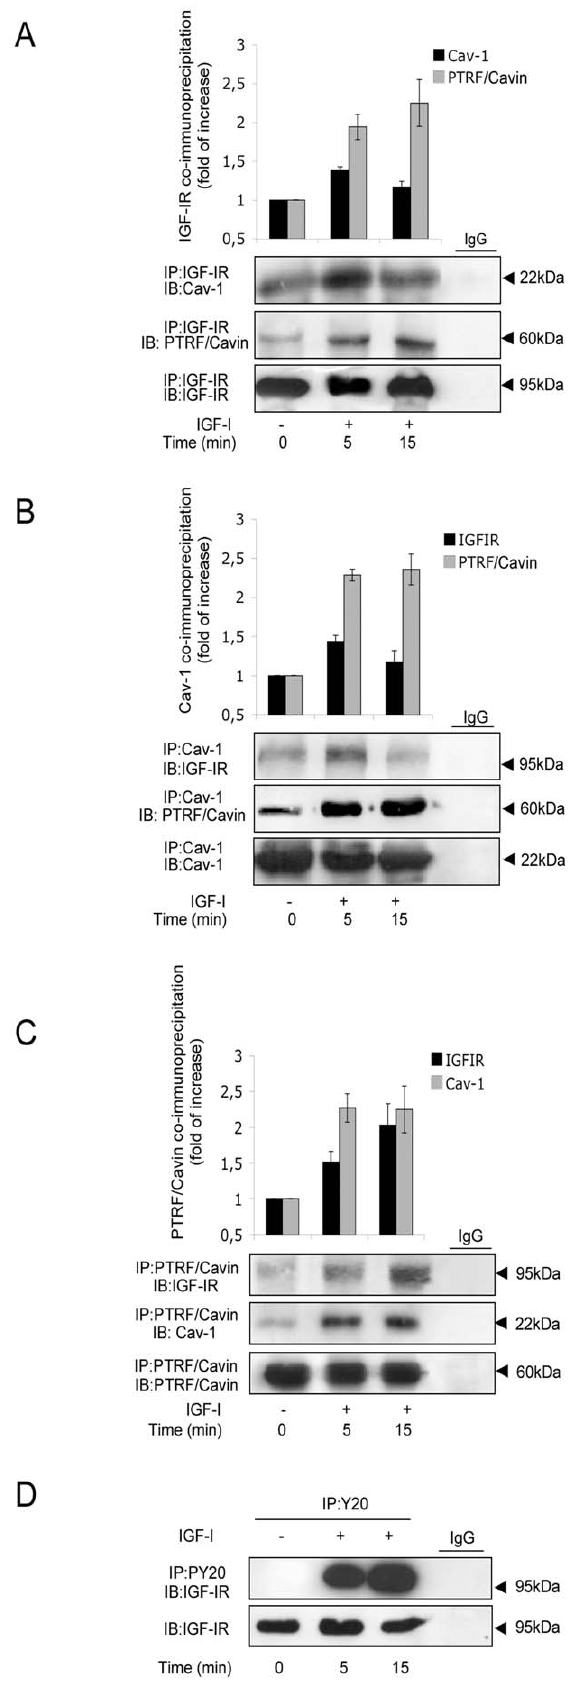
Figure 1. Cav-1 and PTRF/Cavin co-immunoprecipitation with IGF-IR. Serum starved HaCat cells were stimulated with IGF110 nM for the indicated times and then lysed. Equal amount of cell lysates were immunoprecipitated (IP) and immunoblotted (IB) with the indicated antibodies. The graphs represent quantification of co-immunoprecip- itation experiments following densitometric analysis of bands and are expressed as fold of increase. Data shown are representative of three independent experiments and are expressed as the mean 6